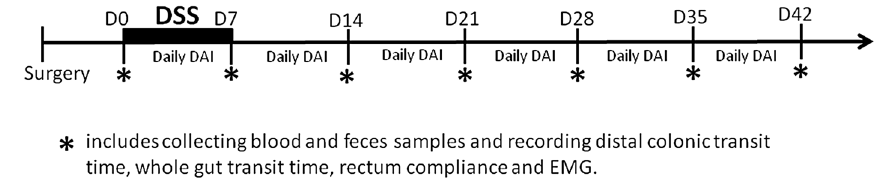
Figure 7. Flow chart of the experiment. After surgery for electrode implantation, 5% DSS water was given to the rats. The distal colon transit time (dCTT), whole gut transit time (WGTT), rectal compliance and EMG were measured with feces and blood samples collected every 7 days. Body weight and feces were recorded daily for the DAI